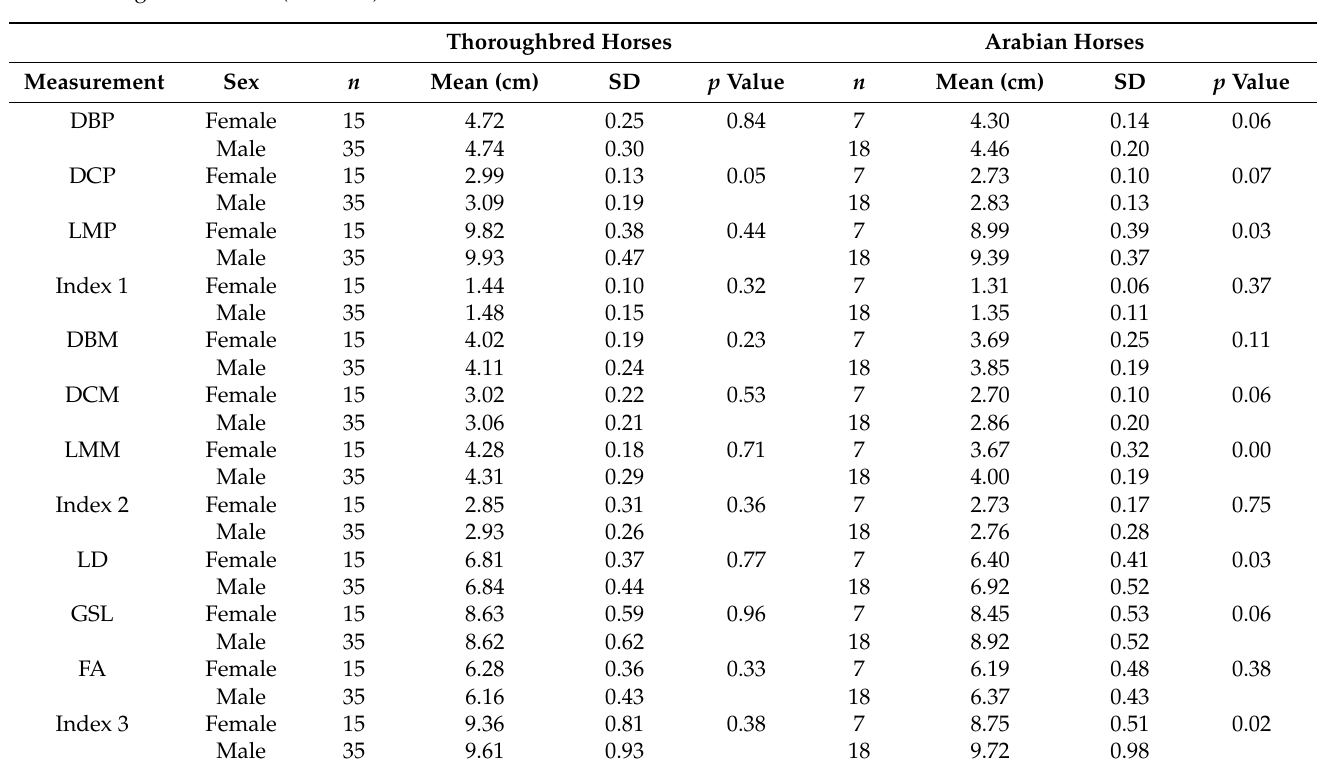
Table 1. Mean values of measurements, standard deviations, and p values determined between sexes of Arabian horses and Thoroughbred horses (ANOVA). Thoroughbred Horses Arabian Horses